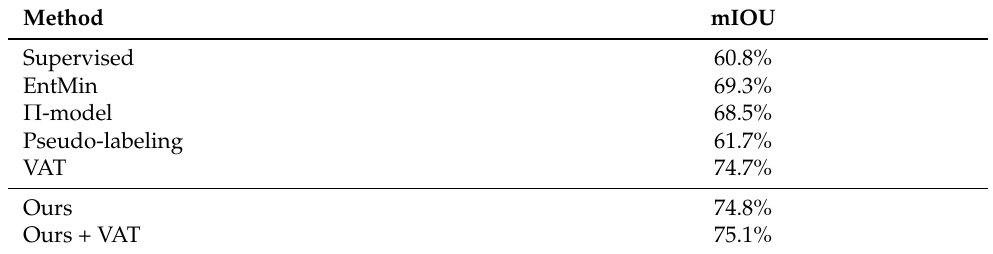
Table 1. Performance on coral images dataset with different semi-supervised